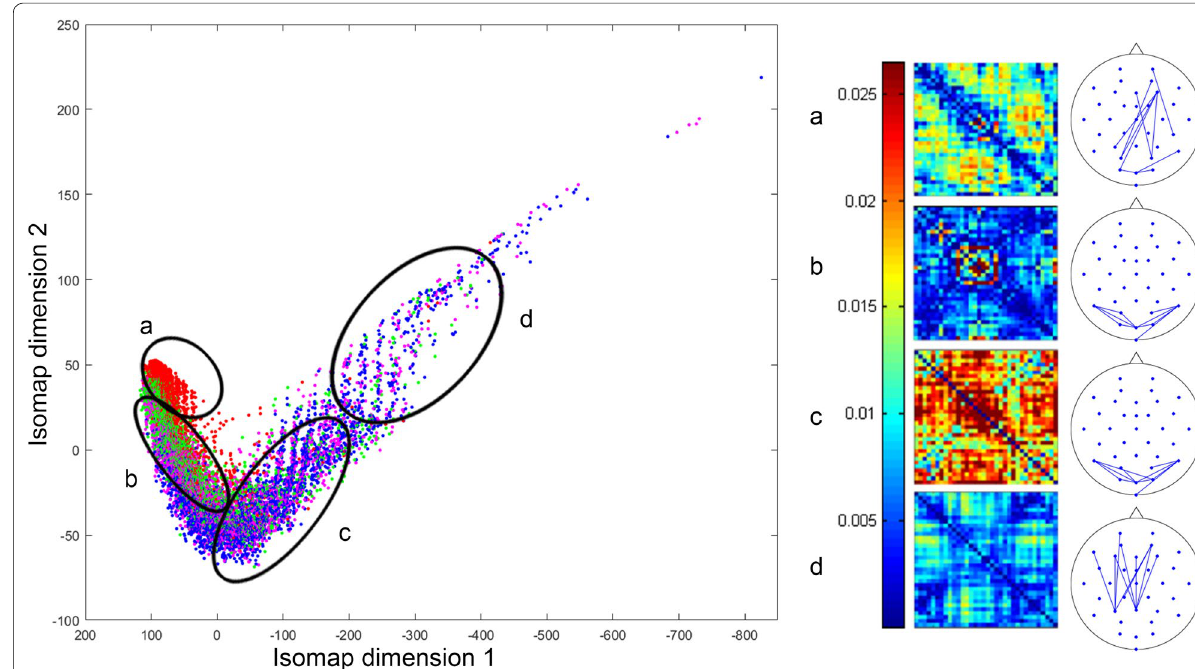
Fig. 4 Mean 34 × 34 theta EEG connectomes of four distinct segments: the head ( a ), the mid and posterior body ( b , c ) and the tail ( d ) (left). For each mean connectome, its ten strongest edges were visualized on the layout of the electrodes (right)